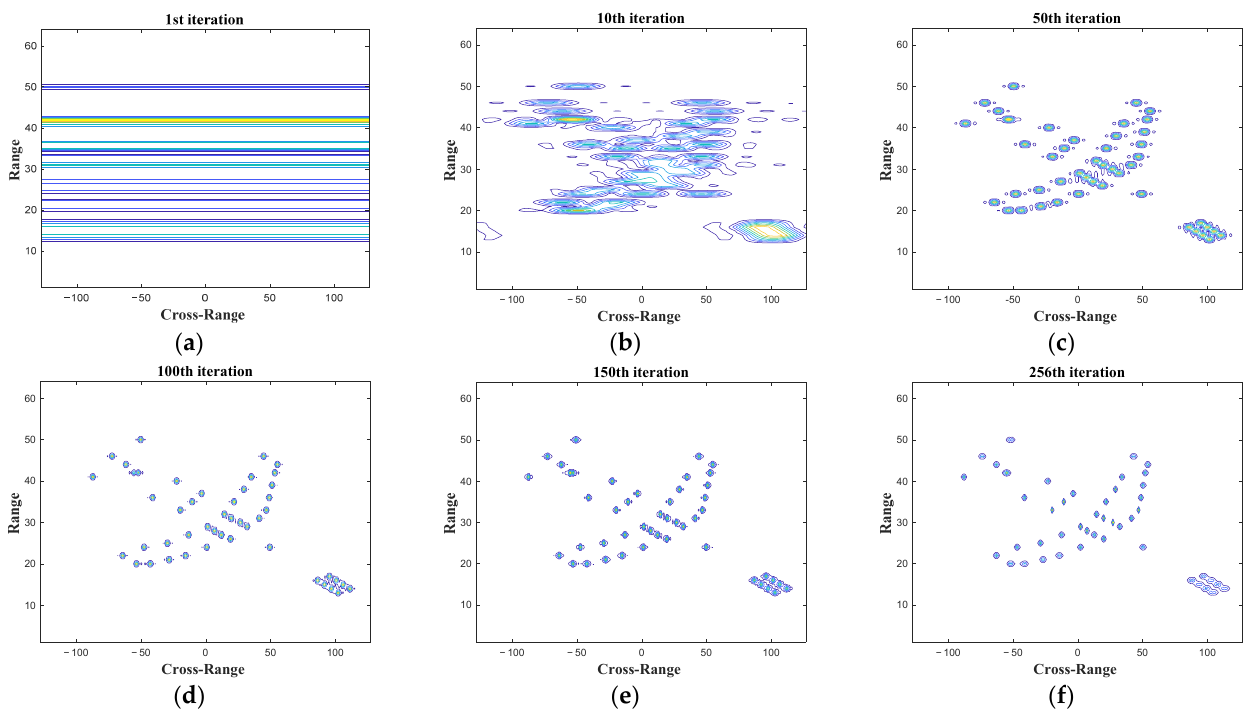
256 M . The KF ‐ tracking mainly relies on the rela ‐